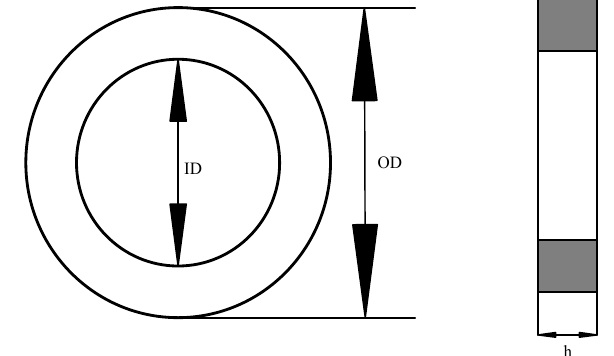
Figure 5. Toroidal Core Dimensions Diagram.